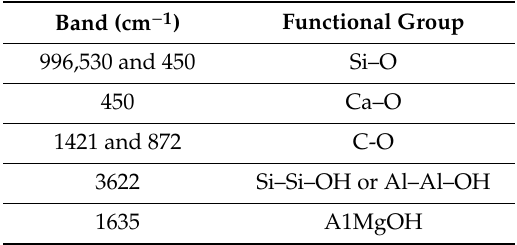
Figure 7. Fourier transform infrared (FT-IR) spectra for iron slag before and after adsorption process. Table 6. Functional groups responsible of benzaldehyde onto iron slag.